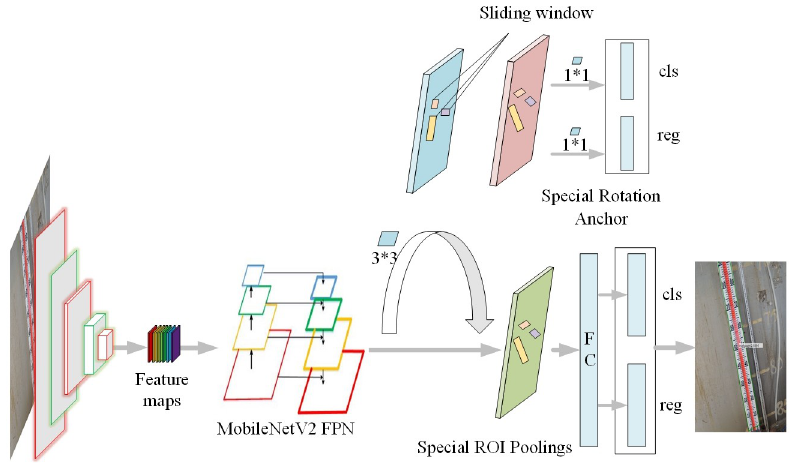
Fig 1. ROMS R-CNN network structure. An inspection example of level gauge is shown in Fig 1. The left structure is a convolutional layer set that produces a set of feature maps by the MobileNetV2 FPN. Sliding through the sliding window can produce anchors of different sizes and rotation angles. Special ROI pooling layers are used to unify the size of candidate areas. As a result, we can get the identified and located level gauge.